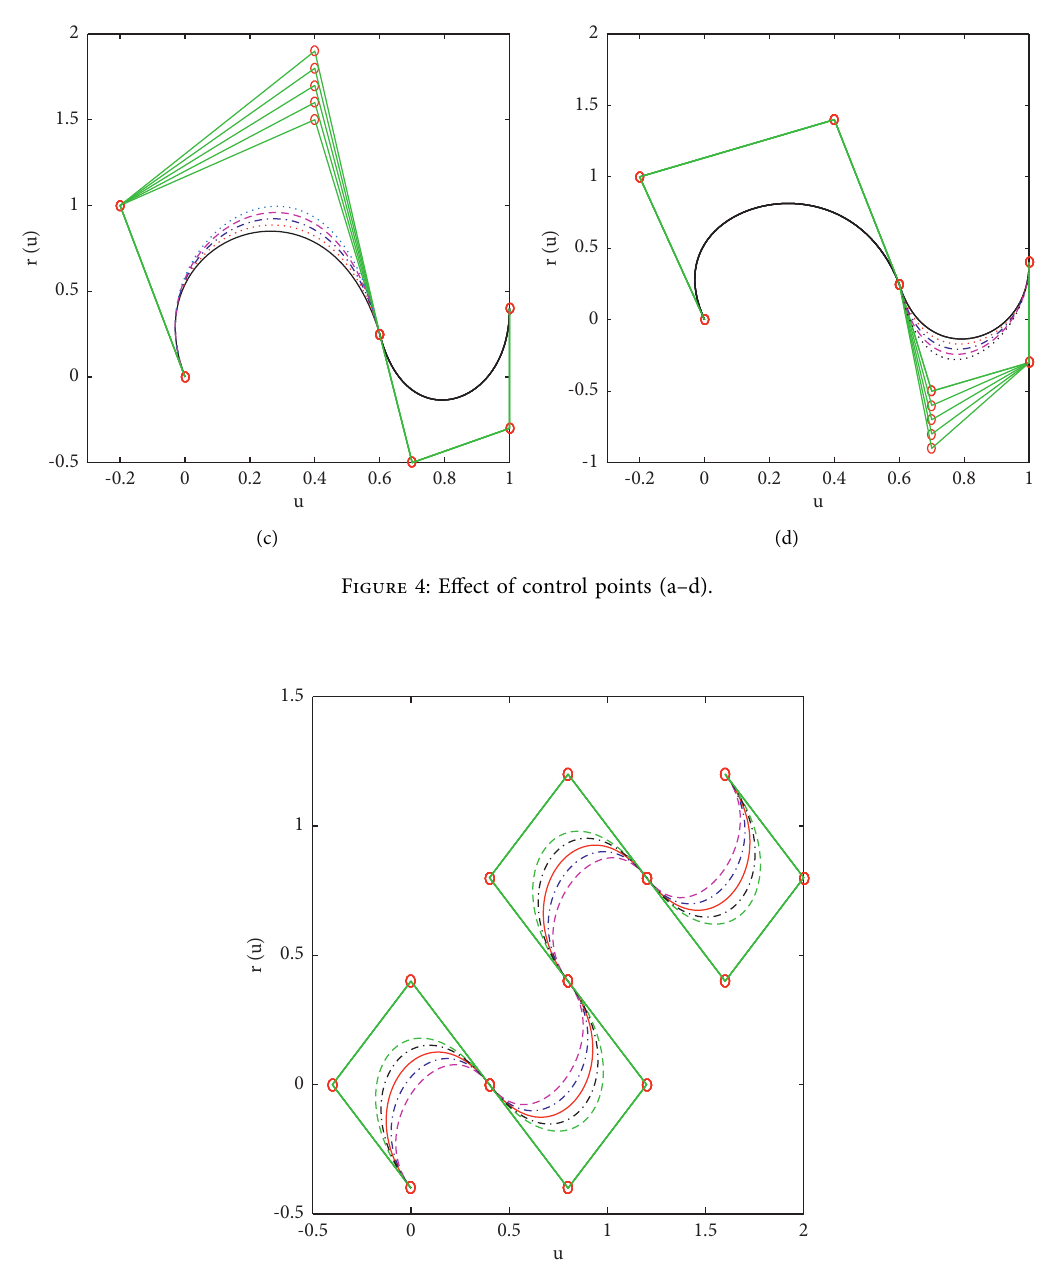
Figure 5: The effect of the shape